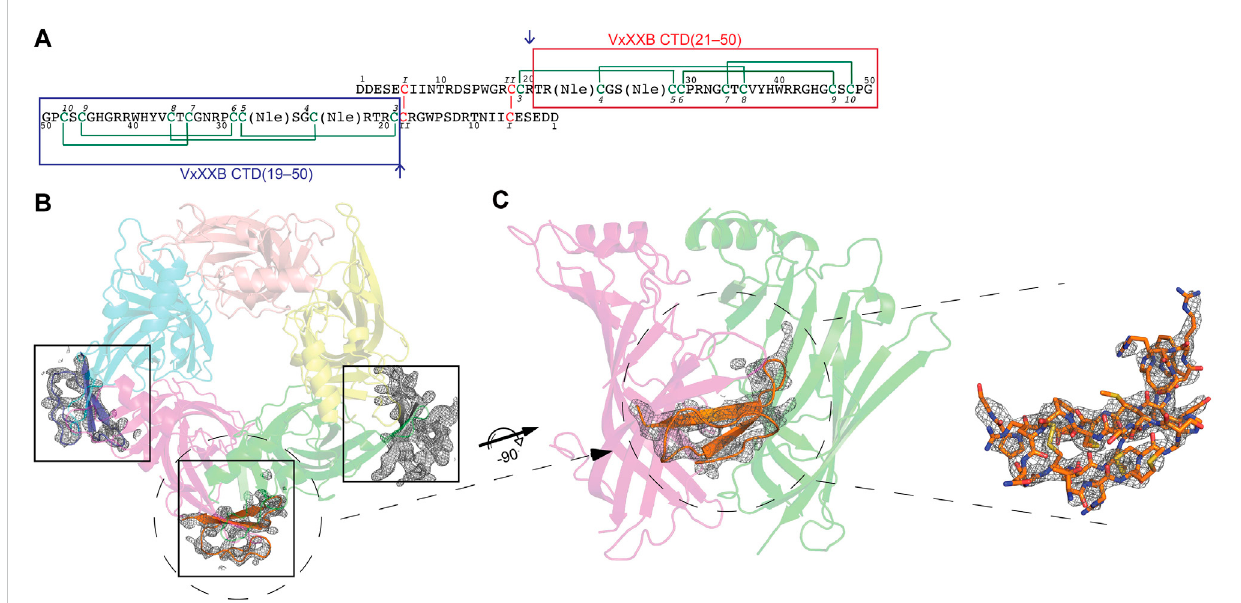
FIGURE 1 (A) Sequence of synthetic VxXXB with VxXXB-C(21 – 50) and VxXXB-C(19 – 50) highlighted in red and blue boxes respectively. α D-conotoxins are a symmetrical homodimer proteins (Loughnan et al., 2006) comprising two C-terminal domains (CTDs) coupled through two interchain disul fi de bonds between the N-terminal domains (NTDs) where the dimerization occurs through Cys6 (Cys I ) of one NTD chain and Cys18 (Cys II ) of the other chain. The co-crystal structure of VxXXB-C(21 – 50)/ Ls -AChBP complex viewed from top (B) and side (C) . Well-de fi ned electron density for VxXXB-C(21 – 50) was seen in only three of the fi ve potential allosteric binding sites. Two Fo-Fc map for VxXXB-C(21 – 50) is contoured at 1.0